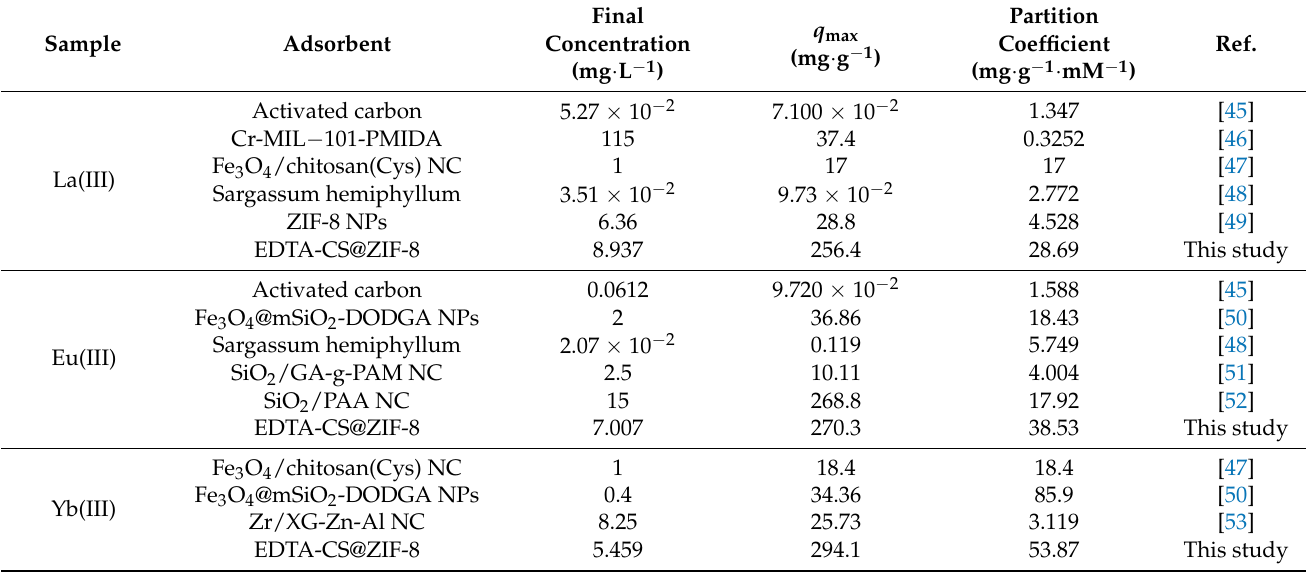
Table 4. Comparison of adsorption properties among several adsorbents in